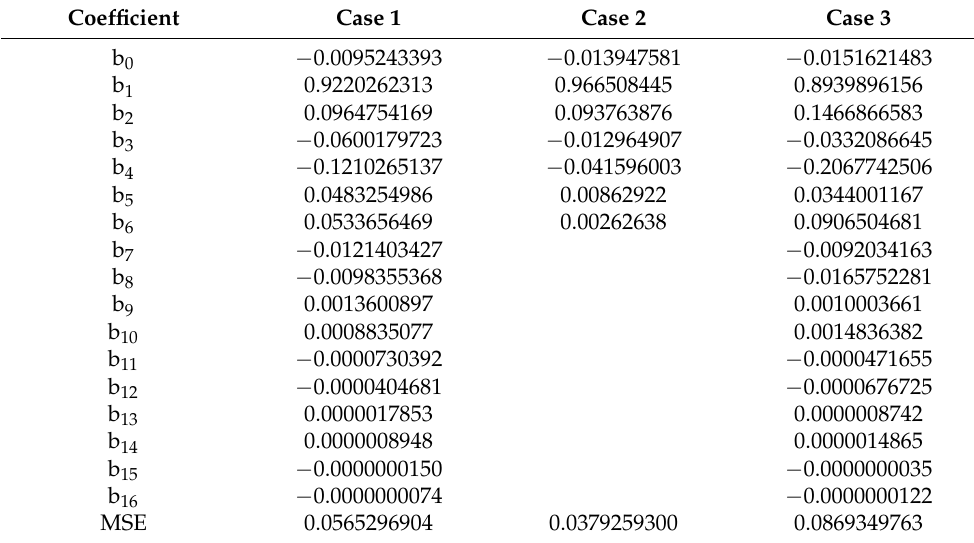
Table 2. The coefficients of curvilinear regression for the expected